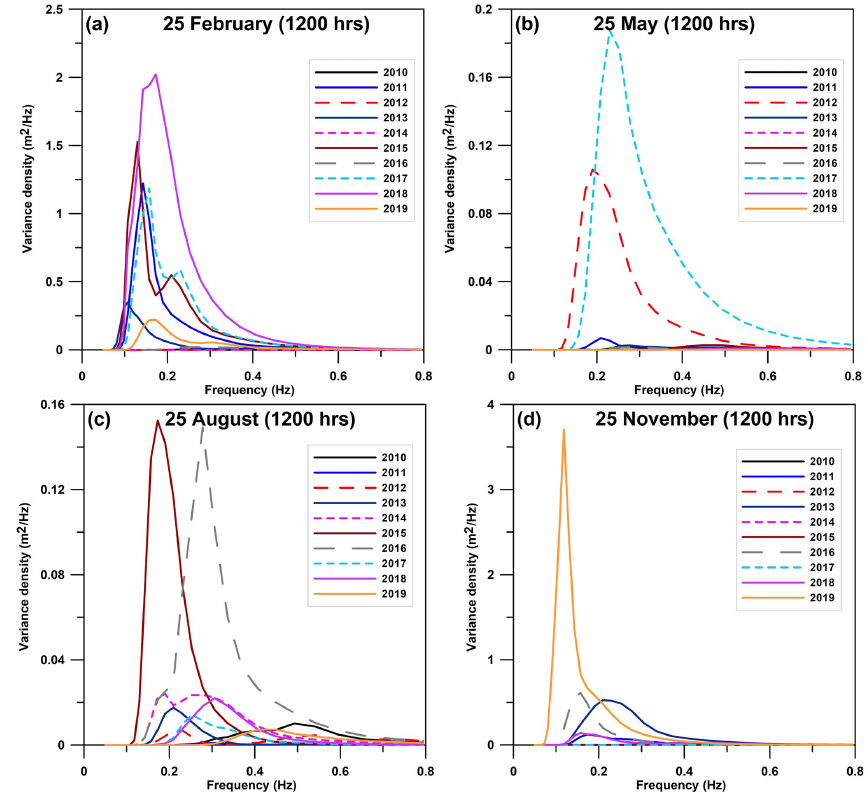
Figure 10. Simulated wave spectra for 2010–2019 on the 25th day (12:00LT) of (a) February (winter), (b) May (spring), (c) August (sum- mer), and (d) November (autumn) at station 6 (Cesenatico; see Fig. 1c for